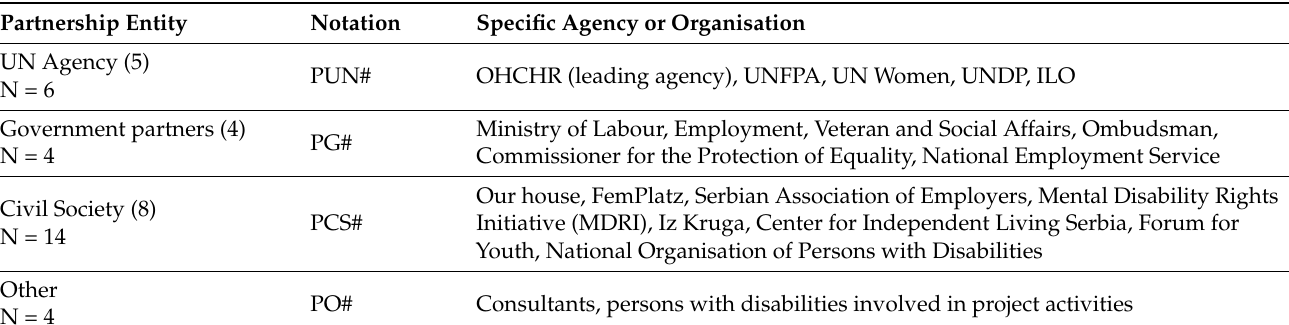
Table 1. List of participants by UNPRPD